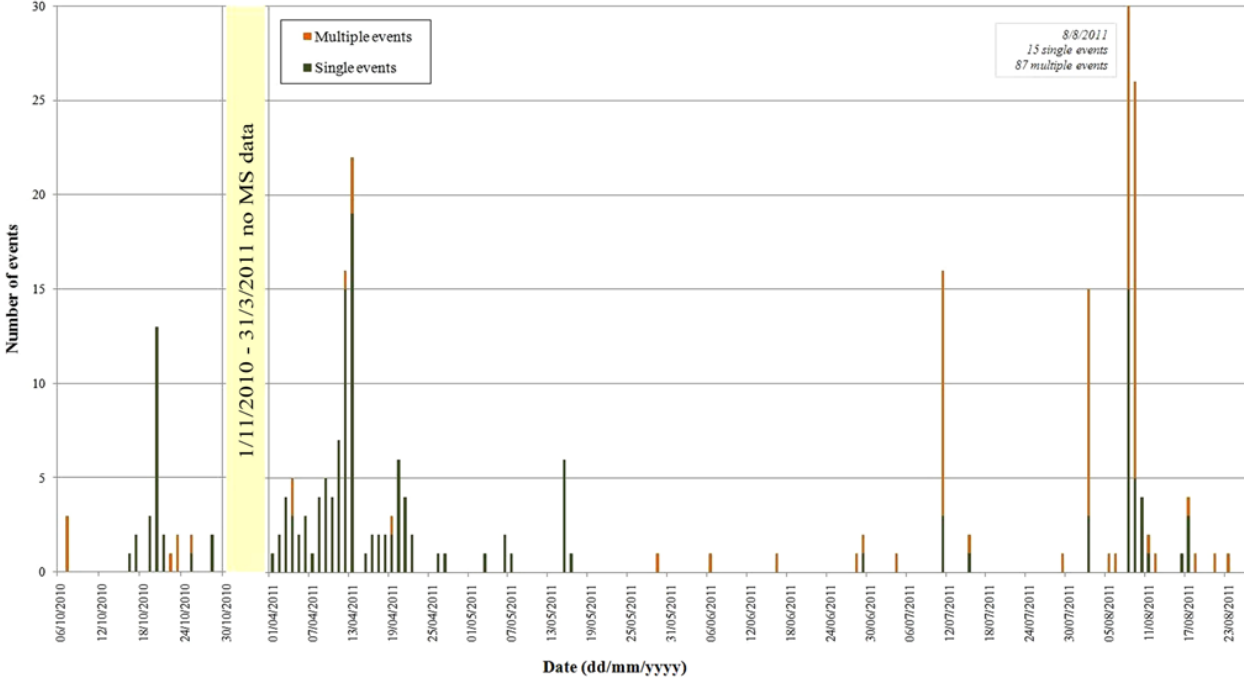
Fig. 6. Temporal distribution of the 329 events occurred between 6 October 2010 and 23 August 2011, classed as single or multiple